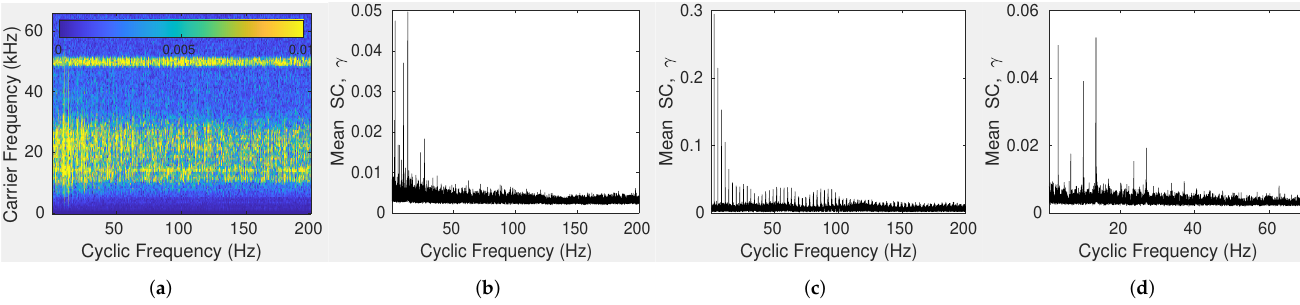
Figure 4. The spectral coherence (SC) of ship-radiated underwater sound at 82% pitch. ( a ) The spectral coherence γ ( α , f c ) plotted as function of cyclic frequency α and carrier frequency f c . The mean spectral coherence γ ( α ) distributions plotted as a function of cyclic frequency α by averaging ( b ) the entire carrier frequency f c range, ( c ) between 48 kHz and 52 kHz in the carrier frequency f c range, and ( d ) the entire carrier frequency f c range, excluding 48 kHz to 52 kHz. The ship’s cyclostationary cavitation noise shaft frequency SF first to fourth harmonics are prominent in ( d